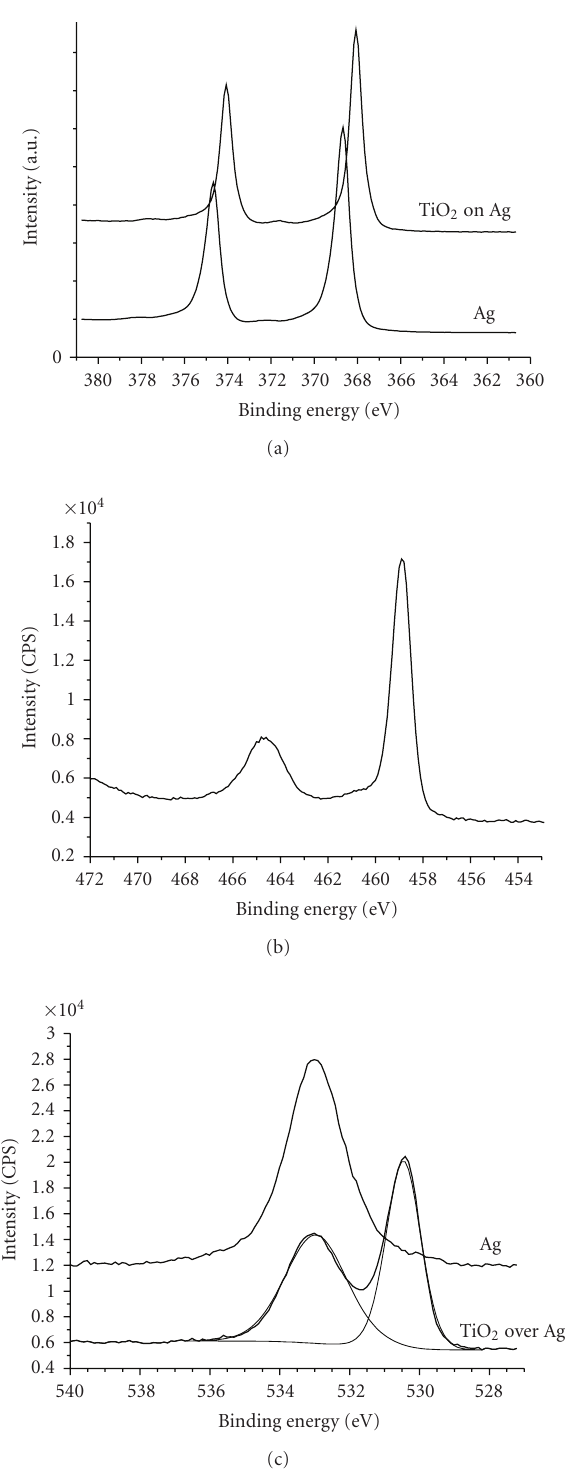
Figure 3: XPS high-resolution scan of (a) Ag 3d TiO 2 over Ag(30) (including sample Ag(30), (b) Ti 2p, (c) XPS high-resolution scan for O 1s.